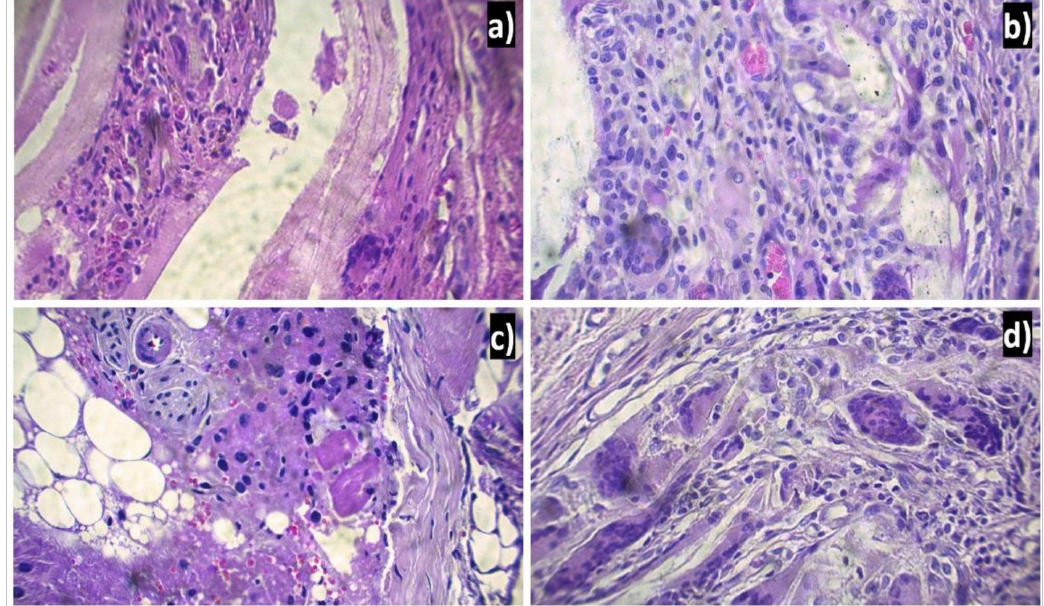
Figure 6. Histological preparation in tissue hematoxylin-eosin with the PCL/Ag seen at 40 × : ( a ) 12 mM, ( b ) 25 mM, ( c ) 50 mM, and ( d ) 100